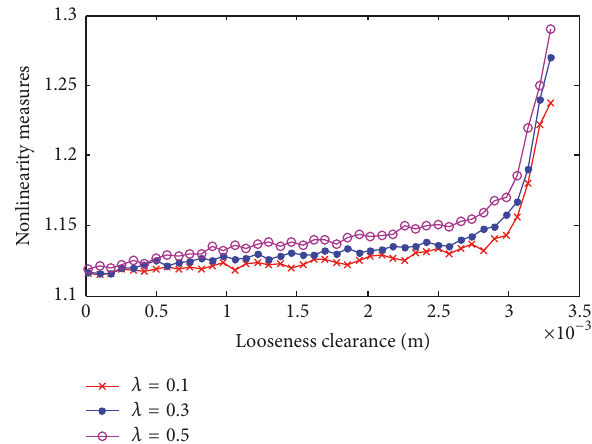
Figure 15: Curves of nonlinearity measure and looseness clearances with different disk mass.